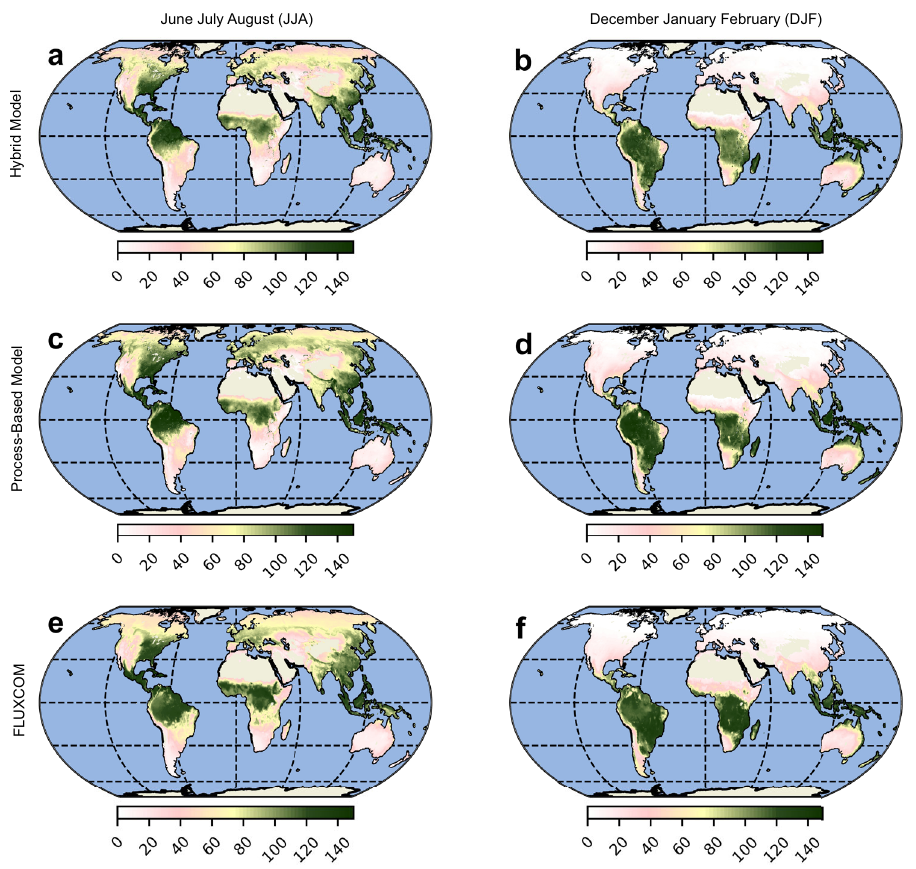
Fig. 5 Global scale evaluation of modeled evaporation. Comparison of the seasonal aggregates of evaporation ( E ) from the processed-based and hybrid models compared with a purely machine learning-based model trained directly on evaporation from FLUXNET sites as the target variable (FLUXCOM 34 ) for JJA a , c , e and DJF b , d , f seasons. Note: The units of E is mm / month